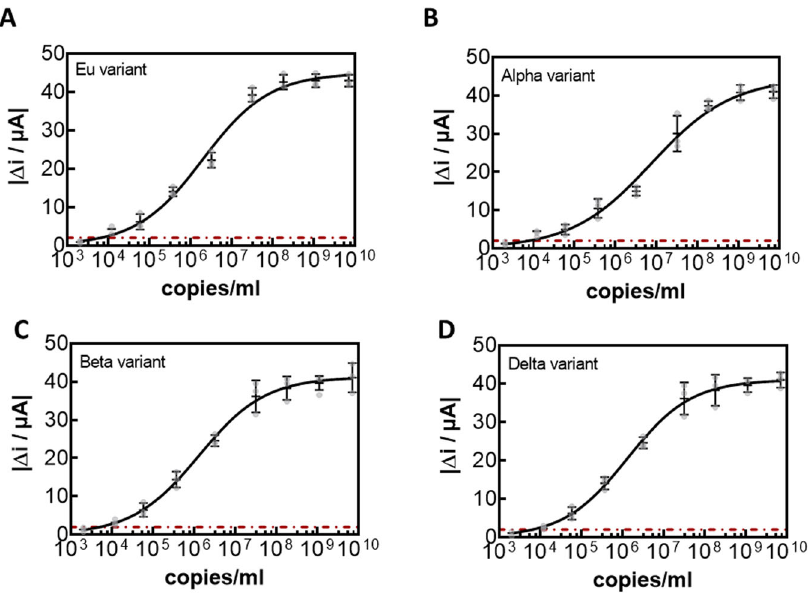
Fig. 6 Dose-dependent response curves of Au-PEG 6 -VHH-72-C13 electrode for different SARS-CoV-2 cultured clades. A clade 20 A.EU2 (EU variant). B 20I/501Y.V1 (Alpha variant). C clade 20H/501Y.V2 (Beta variant). D B.1.617.2 + AY.1 + AY.2 (Delta variant). All results are expressed as the mean ± SEM of at least 3 independent electrodes for each